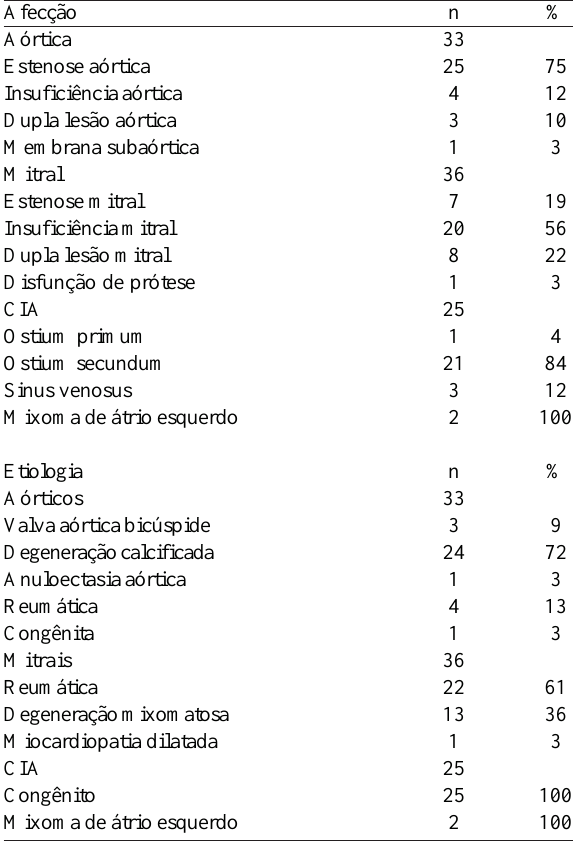
Tabela 2. Dados diagnósticos em 95 pacientes submetidos a operações minimamente